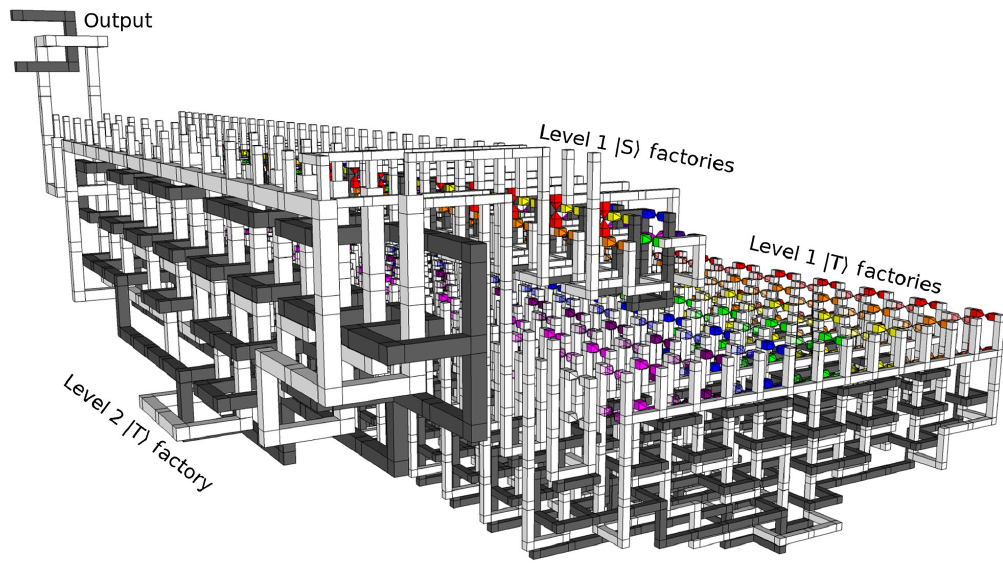
FIG. 24. Preparing a T state in the surface code. Physical j T i 0 states are injected into the 16 lower factories in the lower rear right, which distill them into less noisy j T i 1 states. Fifteen of the successful distillations are forwarded to the larger factory towards the front and left, which distills them into a j T i 2 state with low enough error. The output is shown as the top-left dark